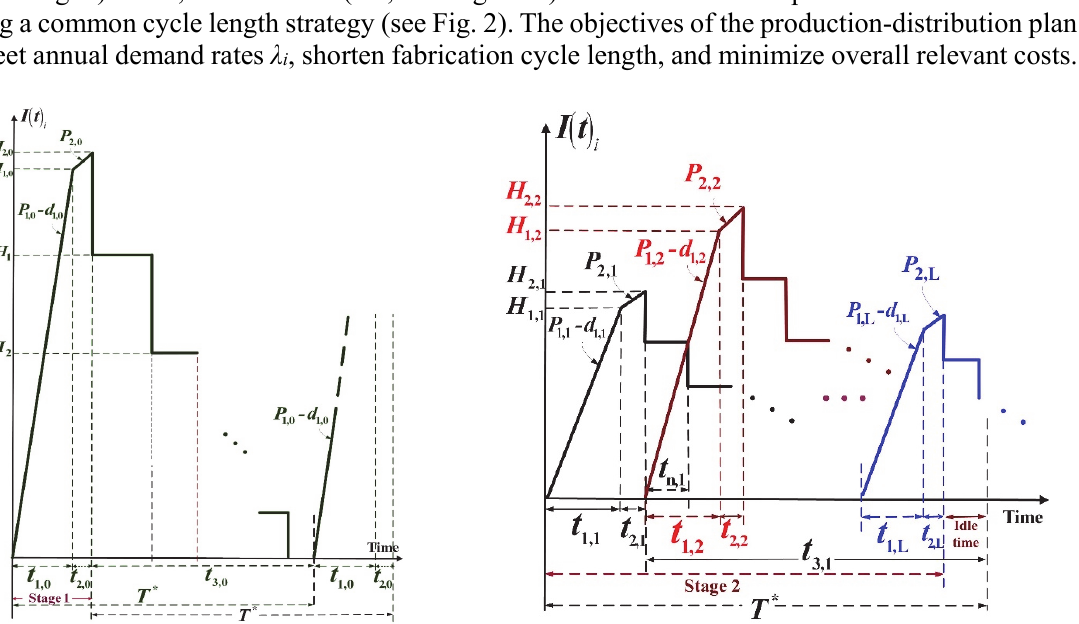
Fig. 1 . On-hand inventory level of perfect quality common parts in stage one of the proposed two-machine two-stage fabrication scheme